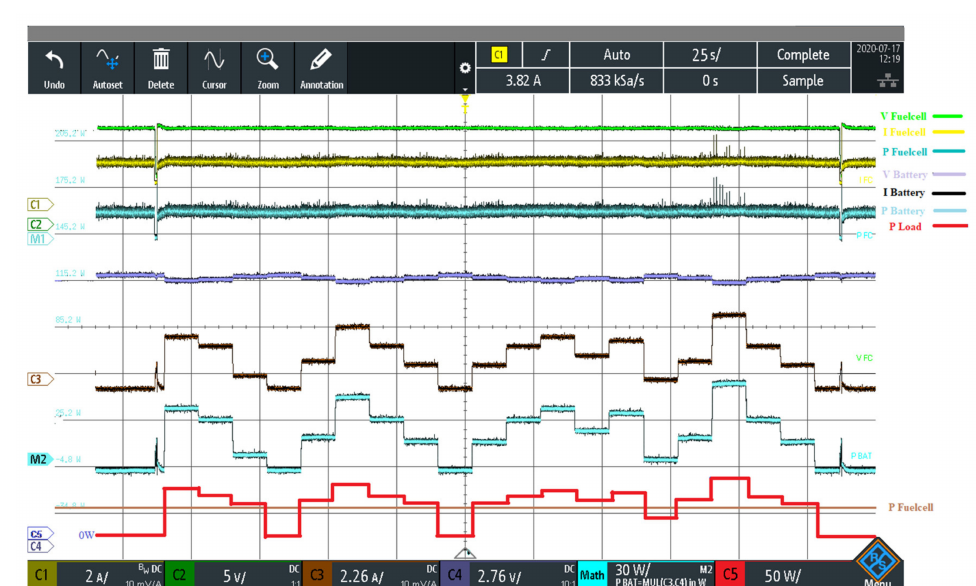
Figure 16. Experimental results based on the new sizing procedure, presenting voltage currents and power.